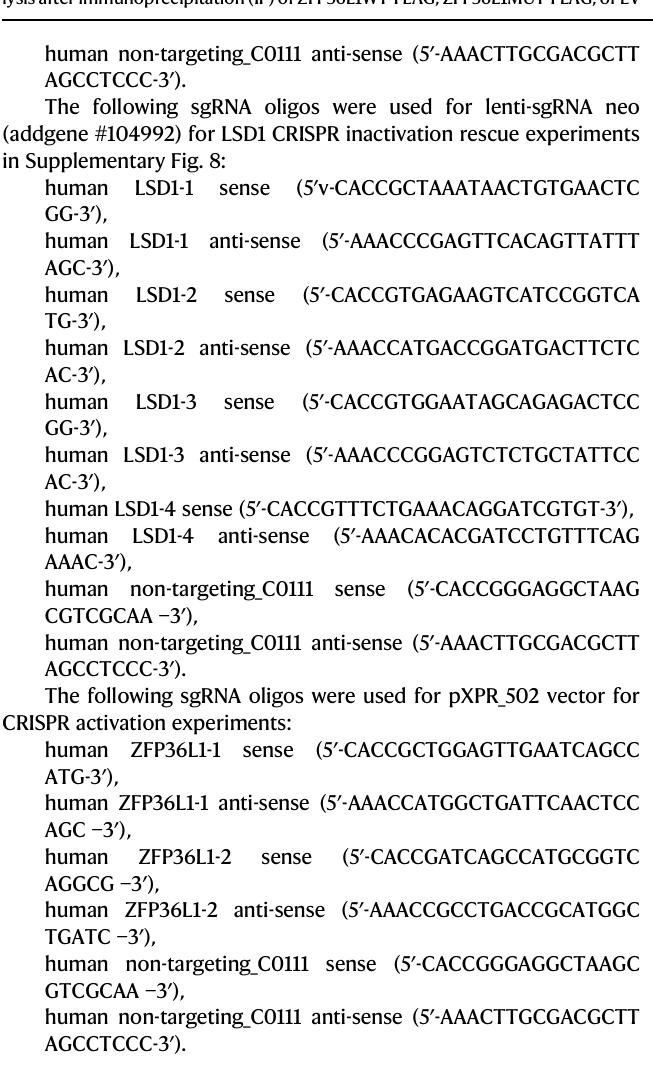
Fig. 5 | ZFP36L1 blocks neuroendocrine differentiation and proliferation in SCLC in part through its ability to bind and degrade the 3 ′ UTRs of SOX2